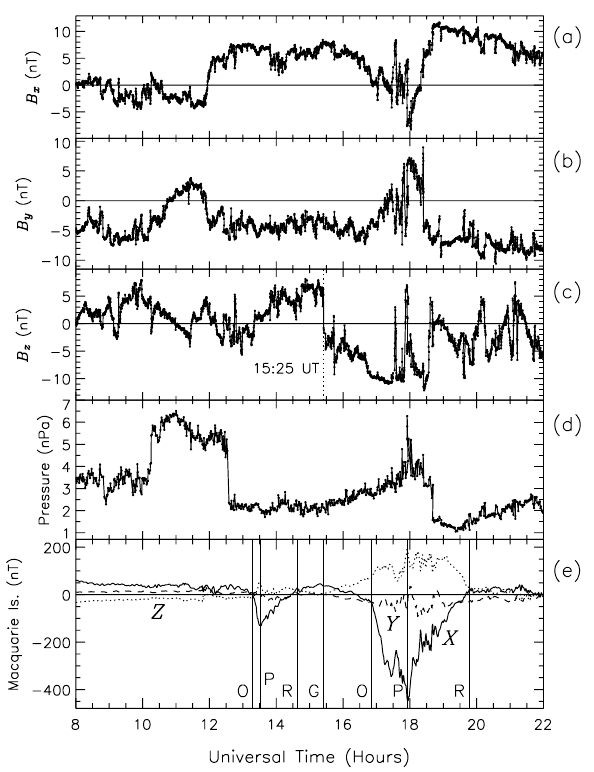
Fig. 2. ACE spacecraft measurements of the IMF (a) B x , (b) B y , and (c) B z components, and (d) the solar wind dynamic pressure, during 08:00 to 22:00 UT on 1 April 2000. The IMF samples are shown at 16-s resolution and the dynamic pressures at 64-s res- olution. (e) Perturbations of the geomagnetic X (solid curve), Y (dashed curve), and Z (dotted curve) components measured by the Macquarie Is. (MQI) magnetometer (provided courtesy of Geo- science